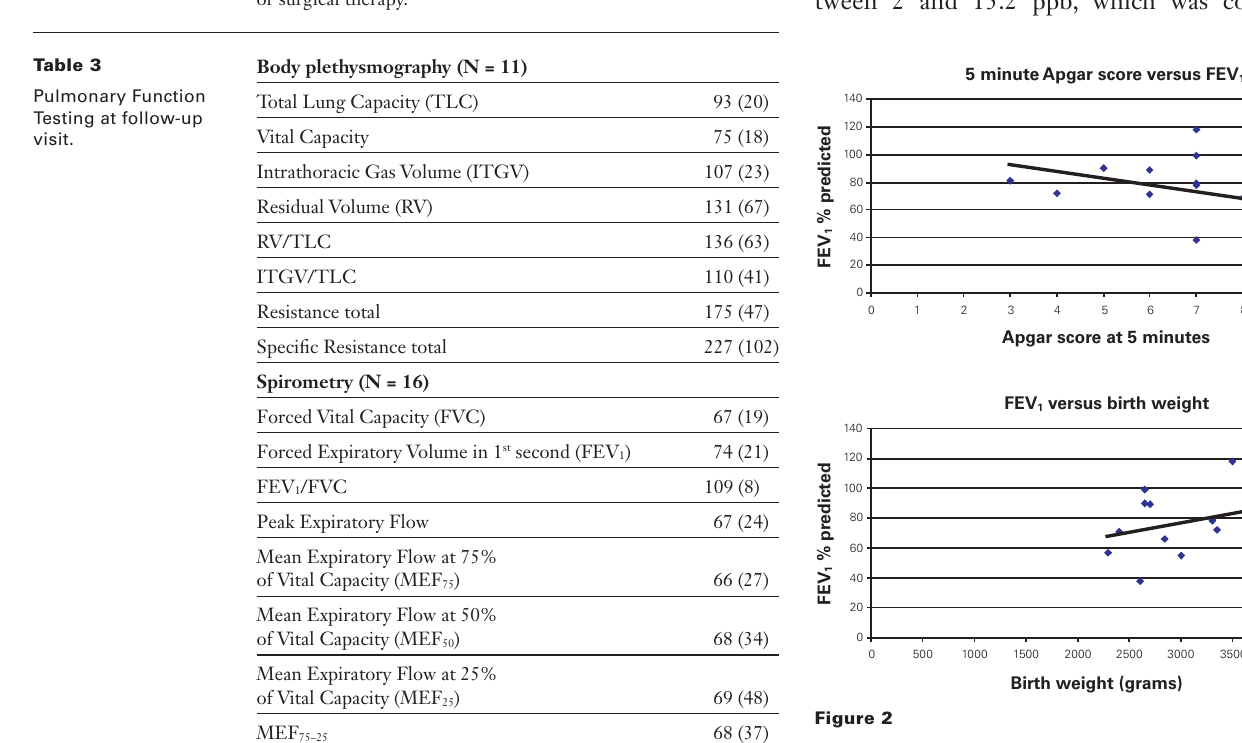
FEV 1 versus Apgar score at 5 minutes and birth weight.